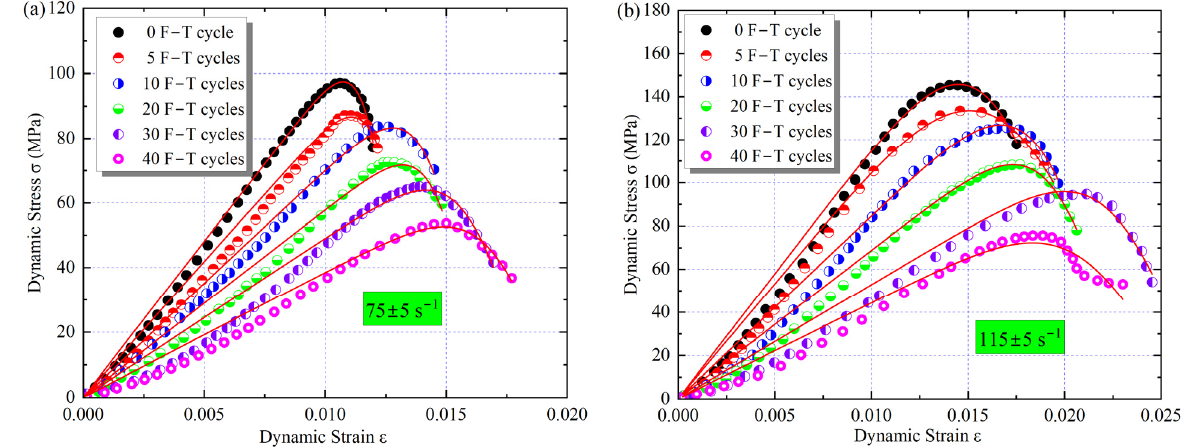
Figure 17. Measured and fitted stress–strain curves at different strain rates and F–T cycles. ( a ) 75 ± 5 s − 1 ; ( b ) 115 ± 5 s − 1 .